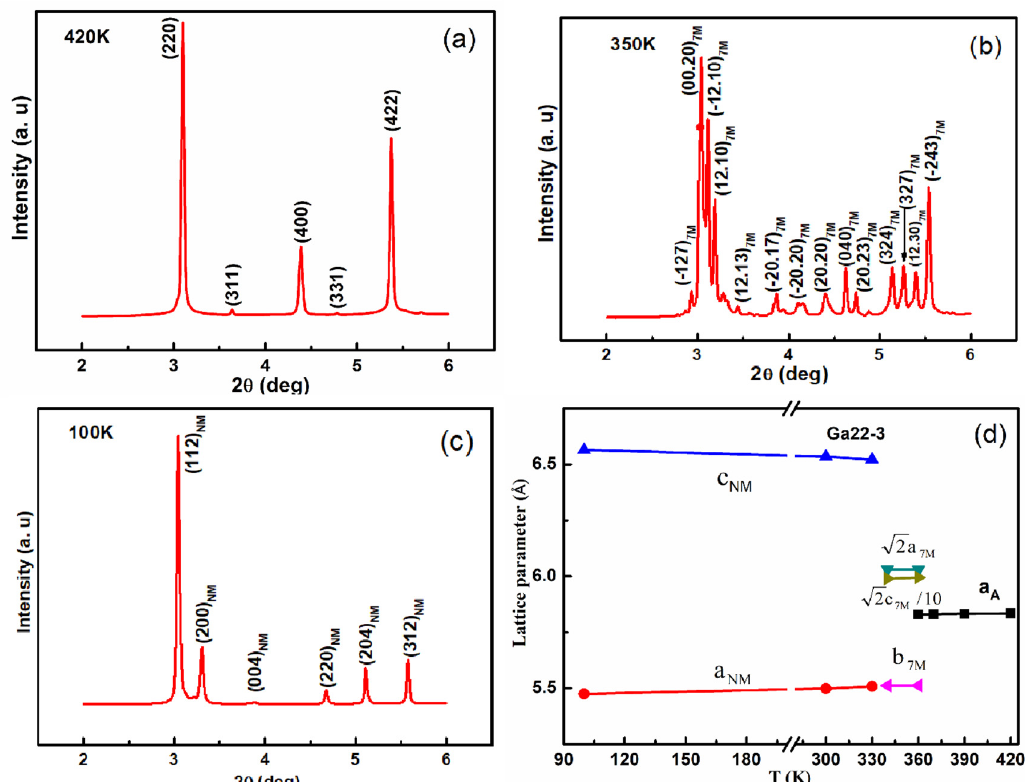
Figure 3. High-energy X-ray diffraction patterns experimentally collected at 420 K ( a ), 350 K ( b ) and 100 K ( c ) for the Ga22-3 ( x = 4) alloy. The corresponding temperature dependence of the lattice parameters is shown in ( d ).